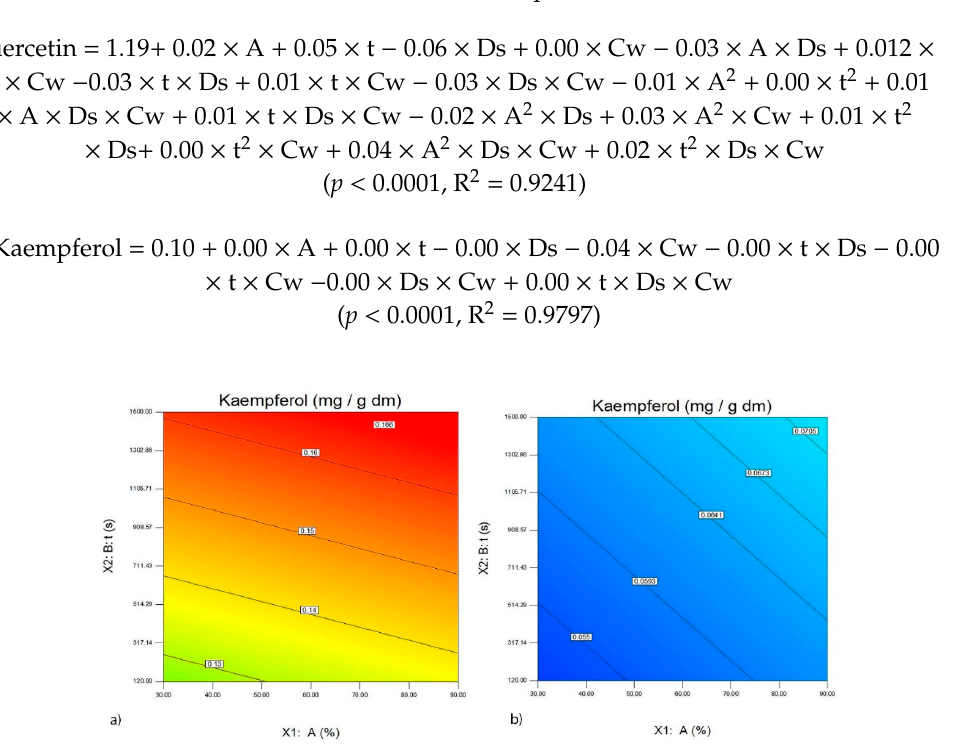
Figure 4. The effect of the probe with a diameter of 22 mm, amplitude A (%) and the time of Figure 4. The e ff ect of the probe with a diameter of 22 mm, amplitude A (%) and the time of ultrasound ultrasound extraction t (s) on the quantity of Kaempferol (mg/g d.m.) in the extracts of the wine lees extraction t (s) on the quantity of Kaempferol (mg / g d.m.) in the extracts of the wine lees of the Merlot of the Merlot variety ( a ) and the wine lees of the Vranac variety ( b ). variety ( a ) and the wine lees of the Vranac variety ( b